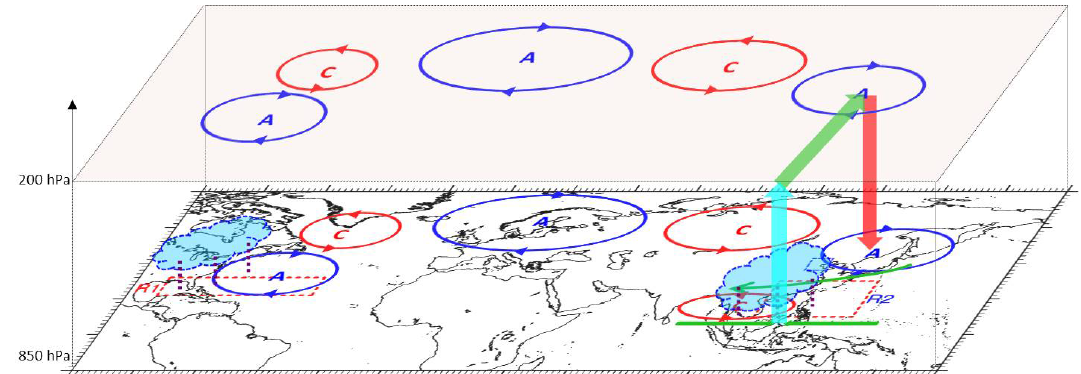
Figure 13. Schematic diagram encapsulating the SSTA-induced (warming in R1 and R2) physical mechanisms and pathways connected to above-normal AHD BTH years on the interannual timescale. Anomalous quasi-barotropic anticyclones (A) and cyclones (C) are indicated by blue and red elliptical cycles with arrows, respectively, denoting large-scale Rossby wave train triggered by the heating to the north of R1. Green arrows depict the key horizontal low-level (850hPa) airflows. The red, azure, and green arrows together exhibit the vertical overturning circulation tied to the SST warming in R2. The left-hand (right-hand) side of the pattern resembling a cloud, with violet short dashed lines, presents the significant anomalous precipitation induced by SSTAs over R1 (R2). The blue dashed box delineates the research domain of the BTH